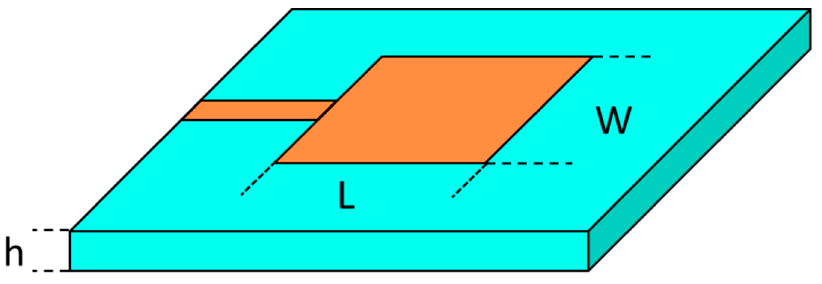
Figure 2. The geometry of the patch antenna.